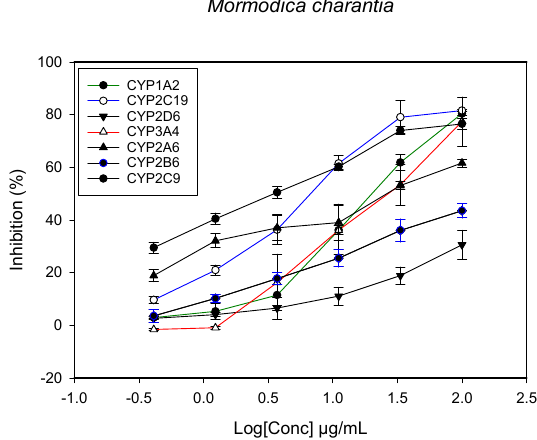
Figure 5. The inhibitory effect of graded concentrations of the extracts of M. charantia on the metabolic activity of cytochrome P450 enzymes.